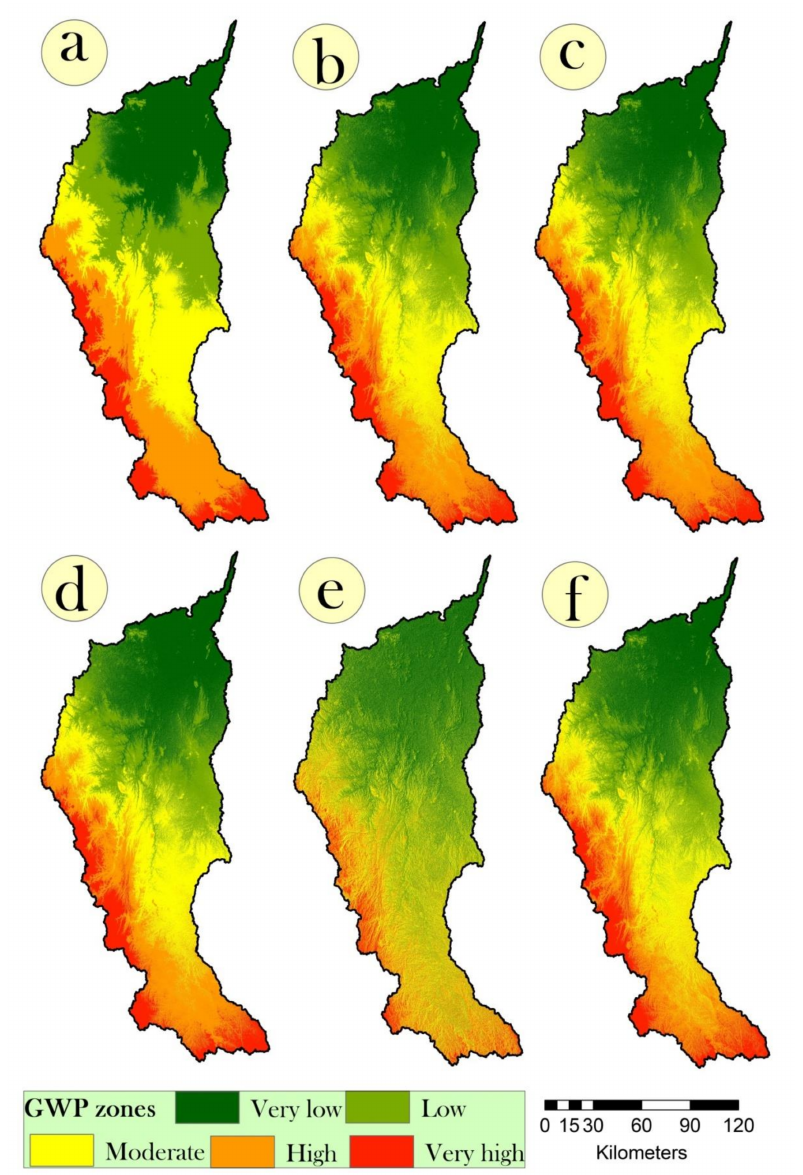
Figure 4. Groundwater potentiality models based on DEM derived parameters using feature selection and fuzzy based hybrid algorithms, such as ( a ) AND, ( b ) OR, ( c ) GAMMA0.75, ( d ) GAMMA0.8, ( e ) GAMMA0.85, and ( f )